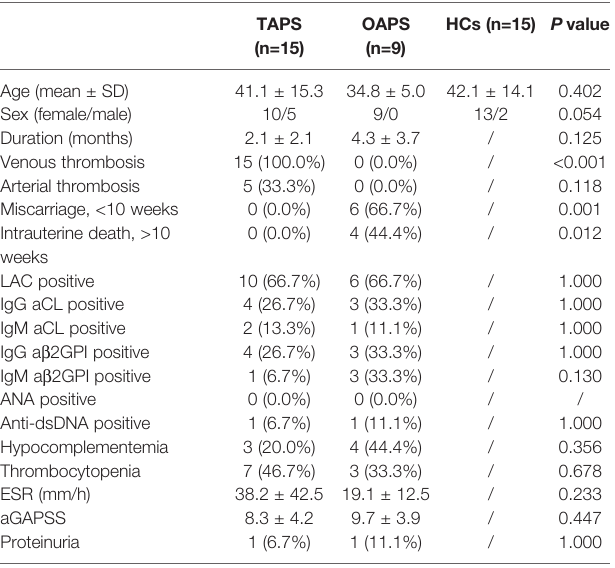
TABLE 1 | Clinical and laboratory features of patients with TAPS, OAPS and HCs in the iTRAQ study.